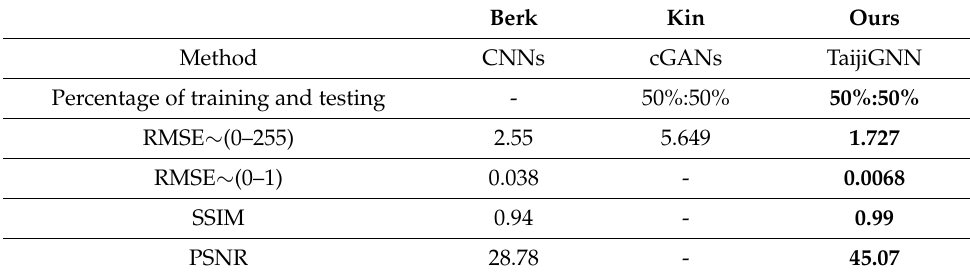
Table 7. The quantitative measurement of converting multispectral image to RGB image [20,21]. Berk Kin Ours Method